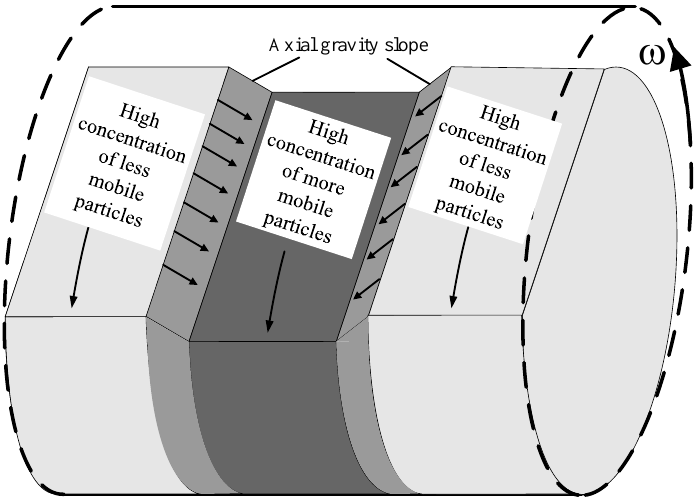
Figure 1. Illustration of three alternating bands along axis of rotating drum. The central band is rich in low friction (more mobile) species while the other two are rich in high friction (less mobile) species. The high friction species exhibit a steeper angle of repose than the low friction species and consequently a gravity slope develops between the bands. More mobile particles are driven preferentially down the gravity slope, resulting in a positive feedback loop that re-enforces the banding